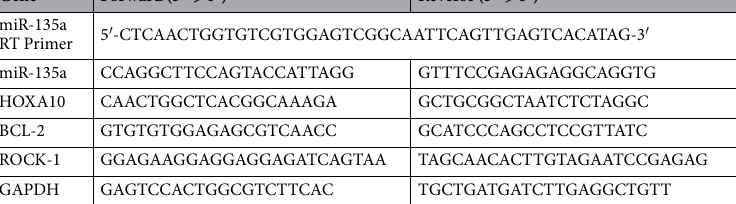
TUNEL assay. Tissues were fixed in 4% paraformaldehyde overnight and embedded in paraffin using a stand- ard histological procedure. A terminal deoxynucleotidyl transferase-mediated dUTP-biotin nick-end labelling (TUNEL) was performed in accordance with the manufacturer’s protocols. TUNEL-positive cells were detected with an Olympus BX61 microscope under 400x magnification. Haematoxylin-eosin (HE) staining. Representative sections (4 μ m) of liver, kidney, spleen, lung, heart and gallbladder were cut and stained with HE and were then scanned with a Scanscope CS slide scanner (Aperio